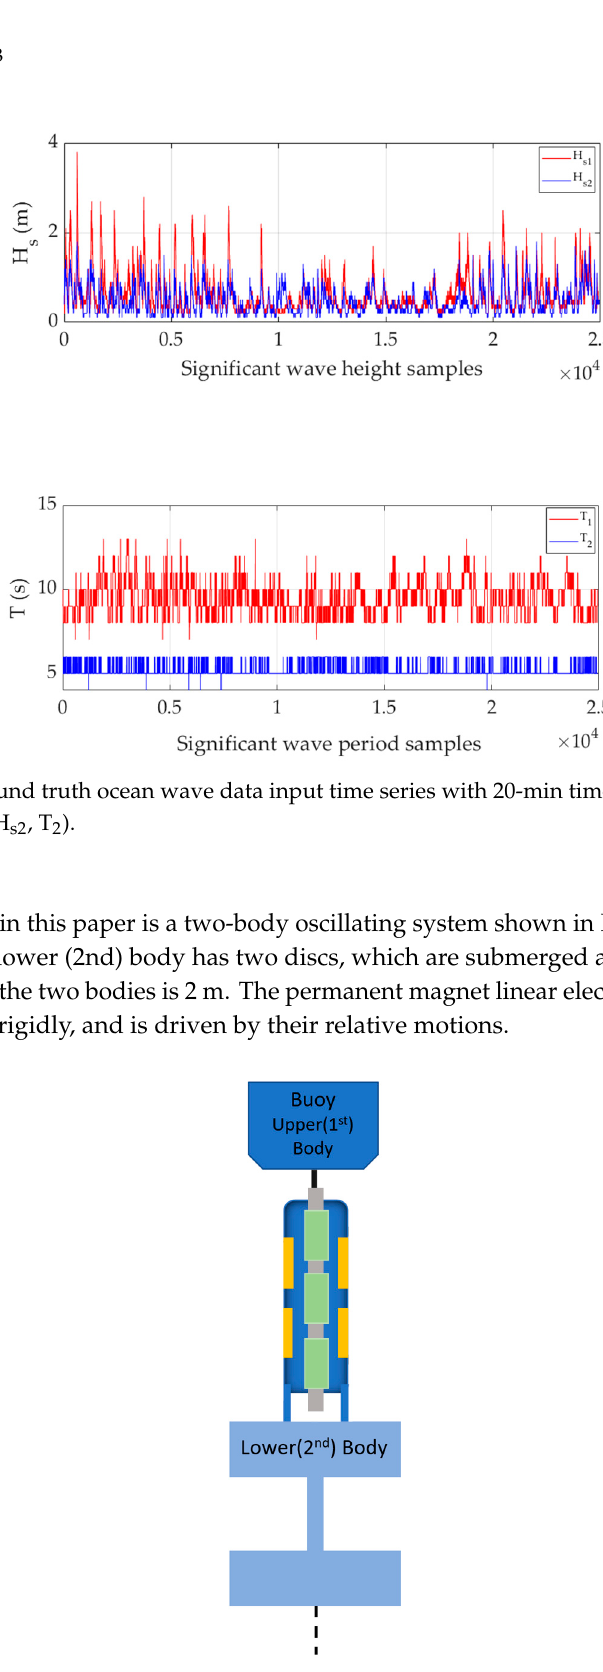
Figure 2. Two-body wave energy converter configuration.